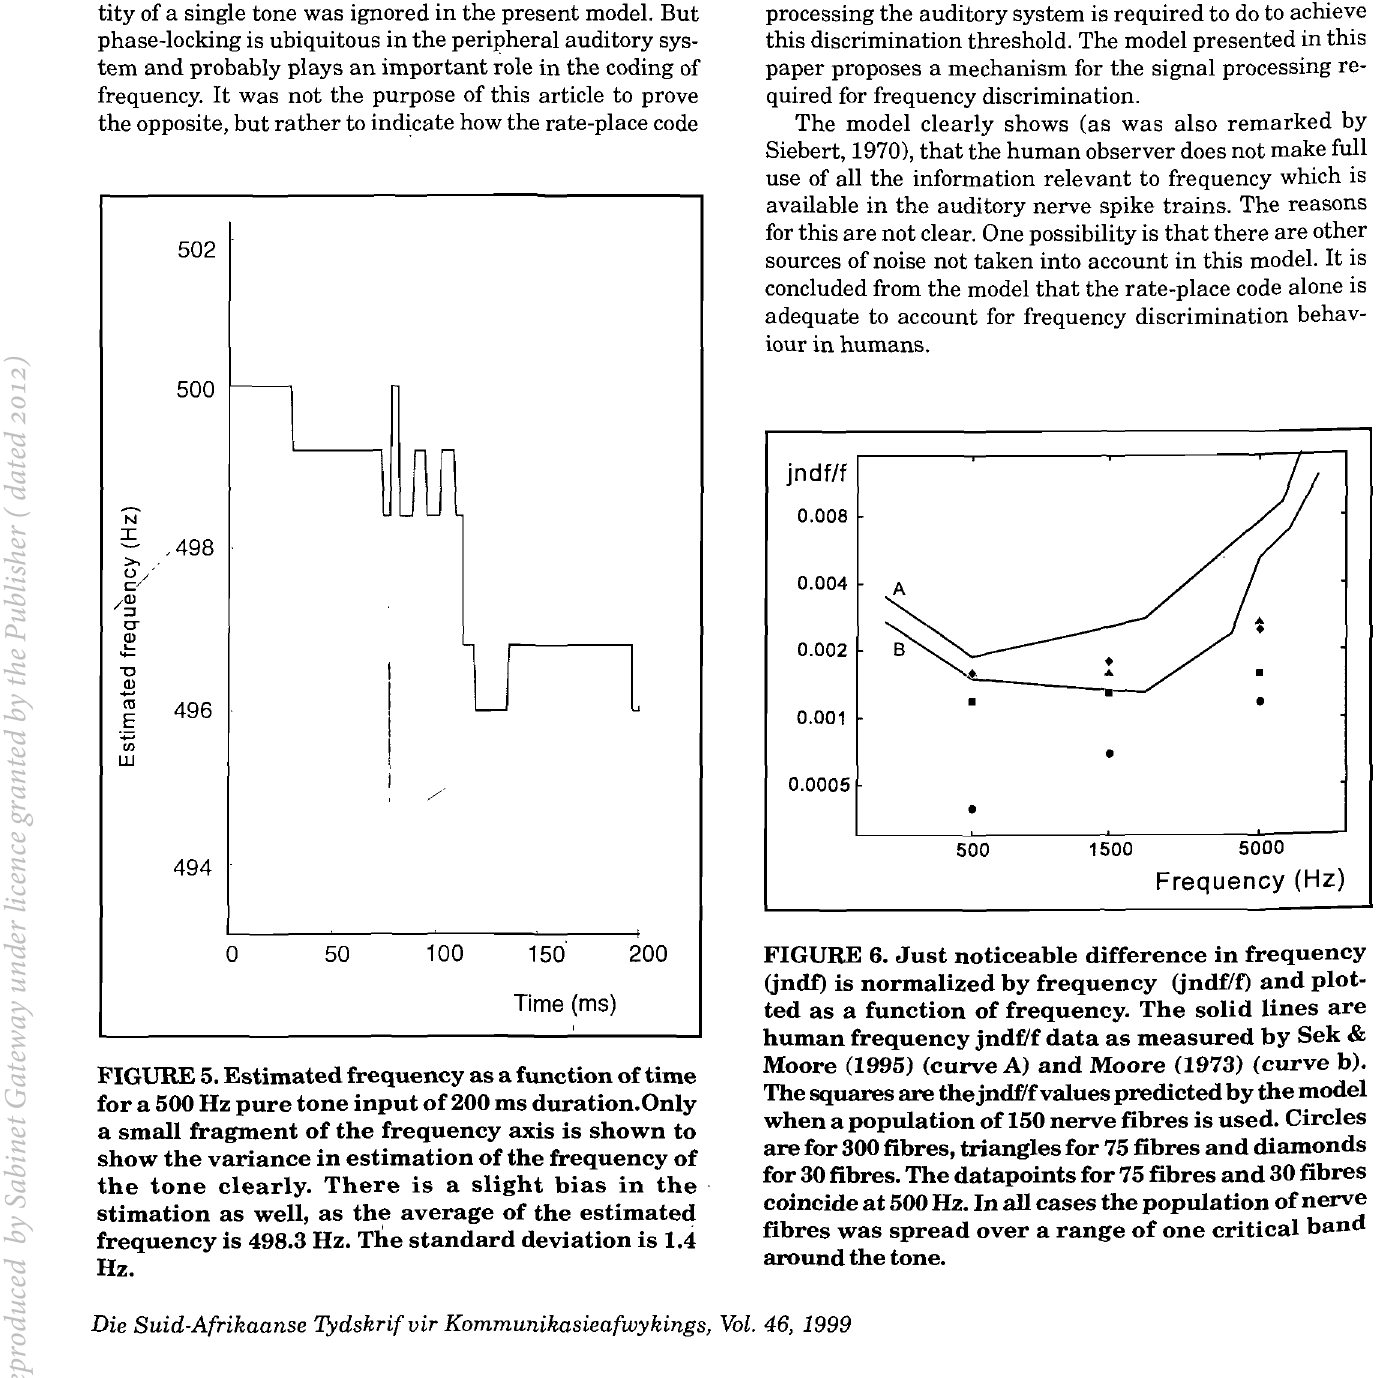
FIGURE 6. Just noticeable difference in frequency (jndf) is normalized by frequency (jndf/f) and plot ted as a function of frequency. The solid lines are human frequency jndf/f data as measured by Sek & Moore (1995) (curve A) and Moore (1973) (curve b). The squares are thejndflfvalues predicted by the model when a population of 150 nerve fibres is used. Circles are for 300 fibres, triangles for 75 fibres and diamonds for 30 fibres. The datapoints for 75 fibres and 30 fibres coincide at 500 Hz. In all cases the population of nerve fibres was spread over a range of one critical band around the